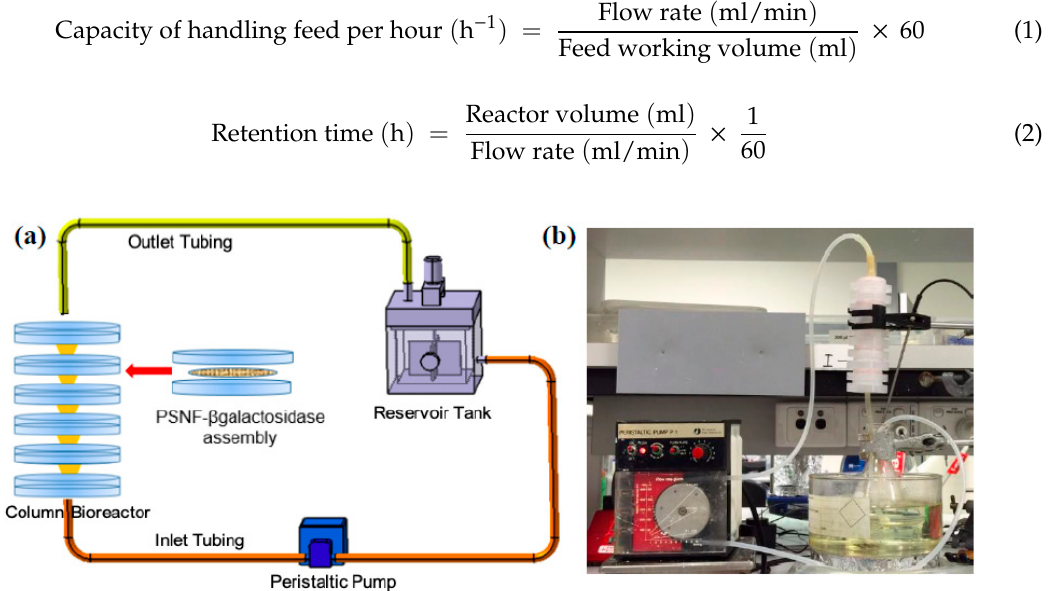
Figure 6. ( a ) Schematic diagram of a recirculating column reactor for lactose bioconversion using a PSNF- β -galactosidase system. ( b ) Actual setup of recirculating column reactor. The conversion and the yield of glucose, galactose, and GOSs were determined using Equations (2)–(5), where brackets represent mass